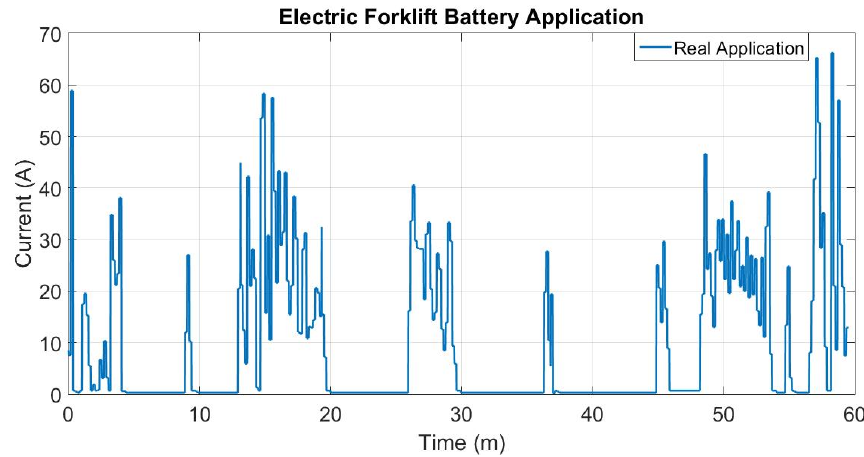
Figure 9. Electric forklift battery application test.